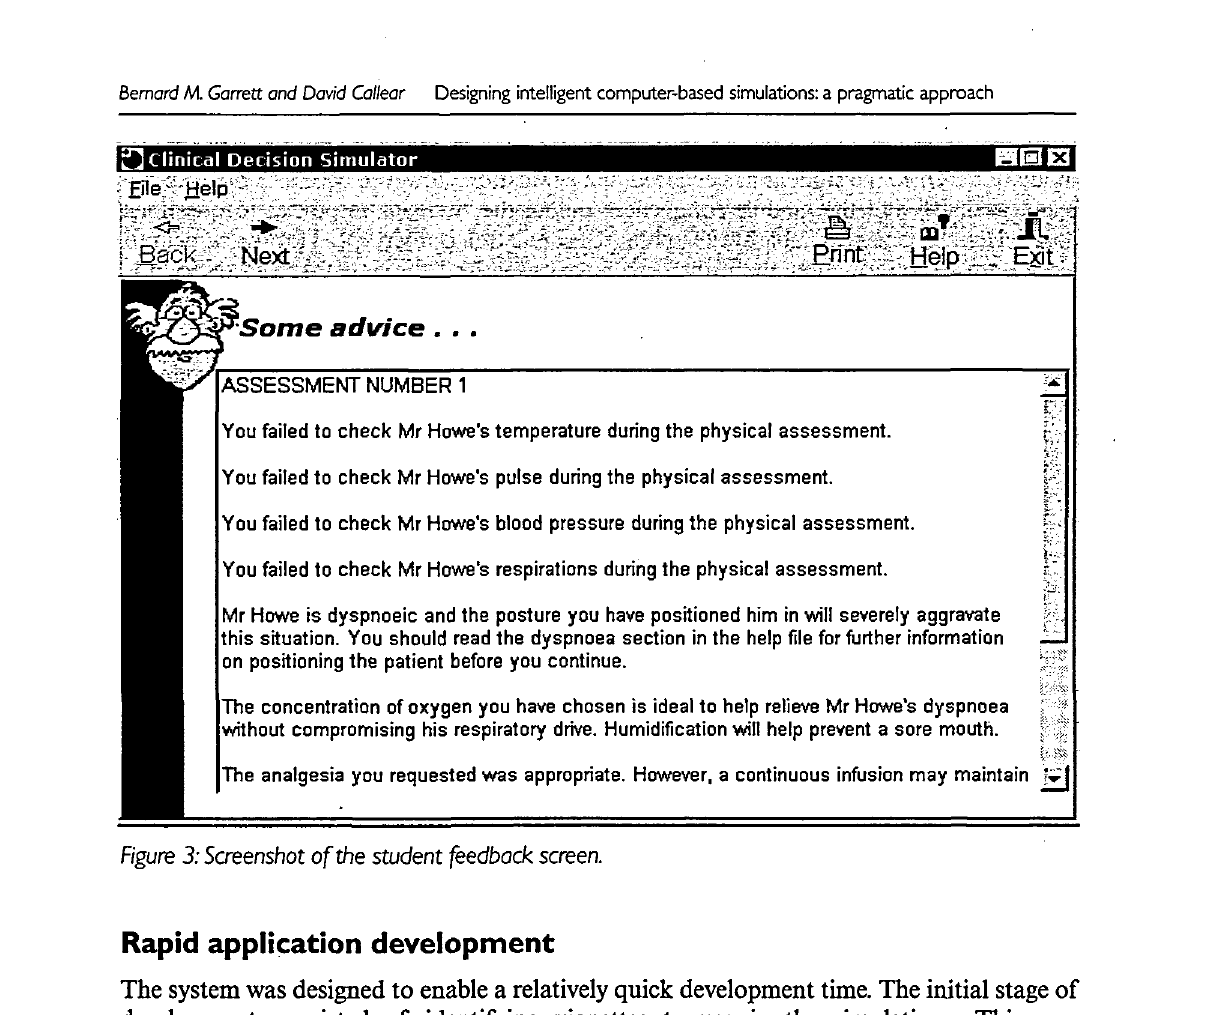
figure 3: Screenshot of the student feedback